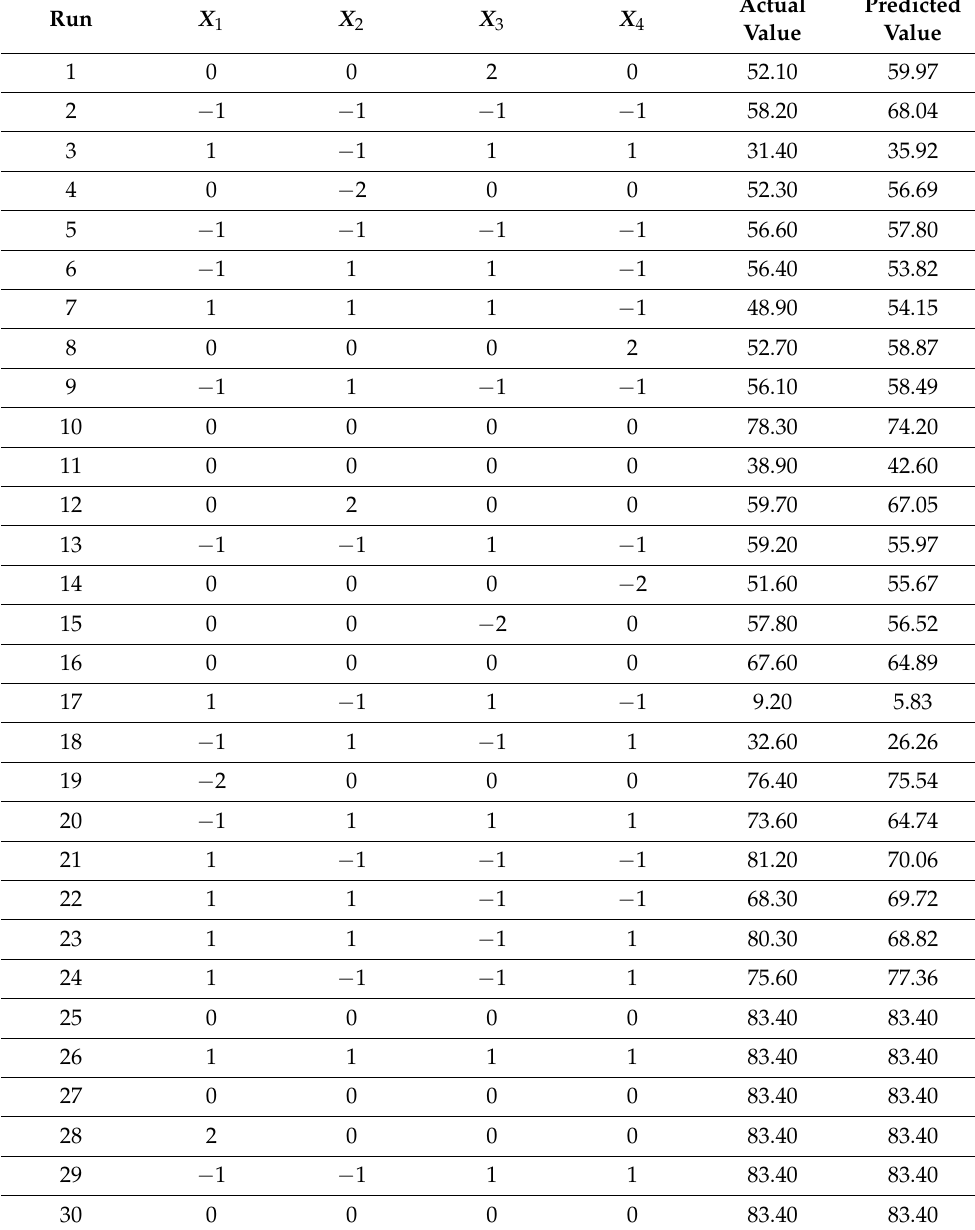
Table 2. Central composite design